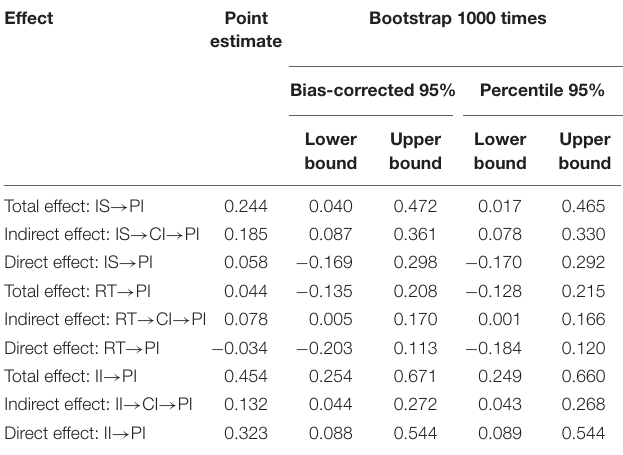
TABLE 6 | The analysis of mediation effect.